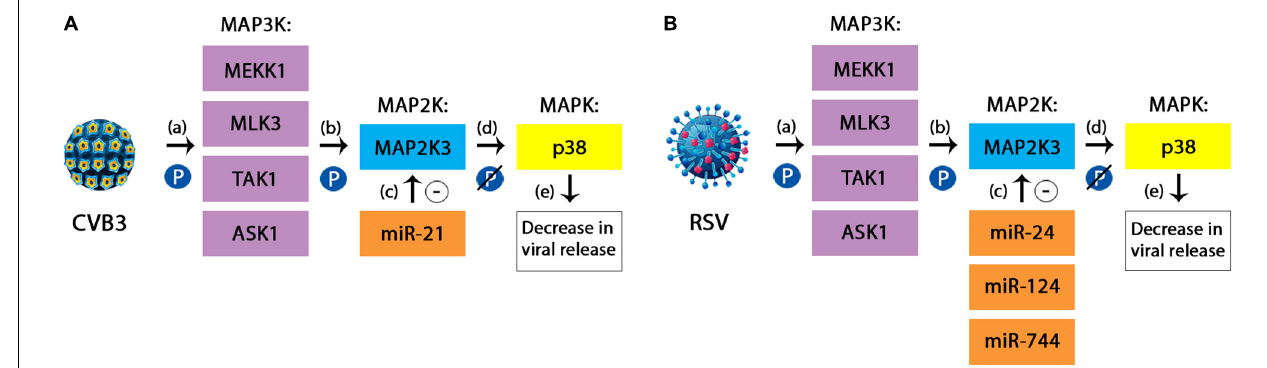
FIGURE 3 | (A) The protective mechanism of miR-21 against Coxsackievirus B3 (CVB3). CVB3 is responsible for activating the p38 component of the MAPK signaling pathway during the course of infection. The simplified mechanism relies on three subsequent phosphorylations, targeting the MAP3K members (a) , the MAP2K (which in the case of CVB3 is represented by MAP2K3 or MKK3) (b) and finally the MAPK, represented here by the p38 kinase. This cascade leads to an increased viral replication in the infected cells. miR-21 has been shown to inhibit the expression of MAP2K3 (c) , therefore leading to a reduced phosphorylation of p38 (d) and consequently, a decrease in the viral release (e) . (B) The protective mechanism of miR-24, miR-124, and miR-744 against Respiratory Syncytial Virus. RSV infection follows the same steps in order to activate the p38 MAPK pathway. In this case, the miRNAs involved are miR-24, miR-124, and miR-744. However, besides the decrease in the activation of p38 component due to a lack of phosphorylation, there has also been demonstrated a reduction in the overall levels of the same member (McCaskill et al., 2017; He et al.,